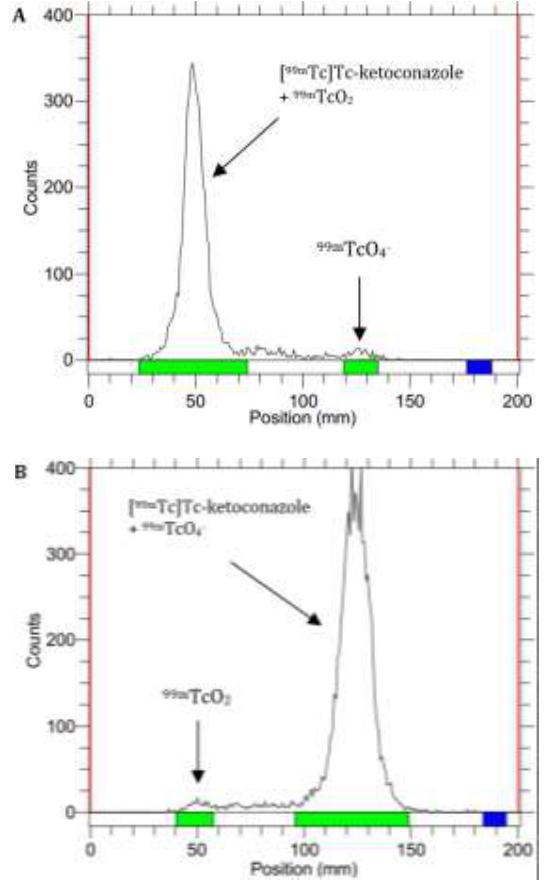
Figure 1. Radiochromatogram of [ 99m Tc]Tc- ketoconazole using acetone as the mobile phase (A) and 0.9% NaCl as the mobile phase